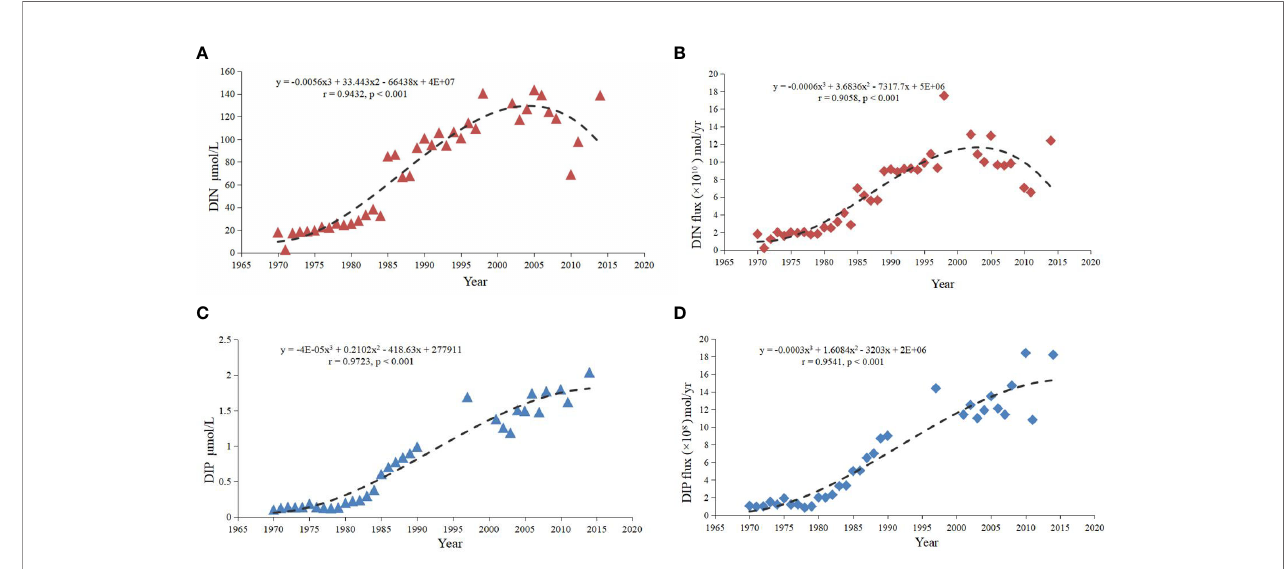
FIGURE 4 | Long-term changes in nutrient concentration (A) : DIN; (C) : DIP and fl ux (B) : DIN; (D) DIP) at Datong Station in